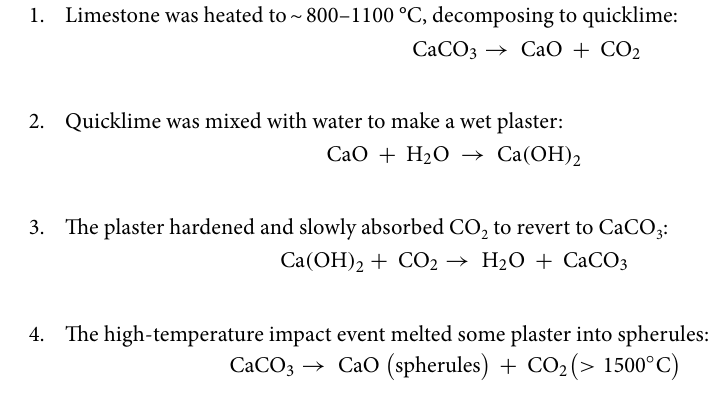
Figure 27. SEM images of a spherule mainly composed of Fe and Si. ( a ) Fe–Ti-rich 54-µm-wide spherule from the palace. Spherule displays a protrusion to the left, suggesting aerodynamic shaping when molten, after which the tail detached. ( b ) A focused ion beam (FIB) was used to section the spherule, revealing inclusions of wassonite or titanium sulfide (TiS; yellow arrows) that are lighter-colored than the matrix. ( c )–( f ) Color-coded SEM–EDS elemental maps, showing the distribution of Ti, S, Si, and Fe and the location of the TiS grains. The spherule is dominantly composed of Fe and Si with minor amounts of Ti and S found in TiS produced emergent droplets at that temperature but did not transform into free spherules (Supporting Informa- tion, Text S2). Similar spherules have been reported from Meteor Crater, where spherules up to ~ 200 μm in diameter are composed entirely of CaCO 3 formed from a cosmic impact into limestone 98,99 . One of several possible hypotheses for TeH is that during the impact event, the limestone plaster converted to CaO with an equilibrium melting point of 2572 °C. However, it is highly likely that airborne contaminants, such as sodium and water vapor, reacted with the CaO and significantly lowered the melting point, allowing spherule formation at ≥ 1500 °C. The proposed chemical sequence of events of plaster formation and the later impact are as follows: